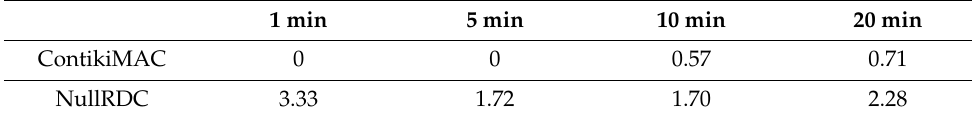
Table 5. Three senders one receiver—packet drop rate %. 1 min 5 min